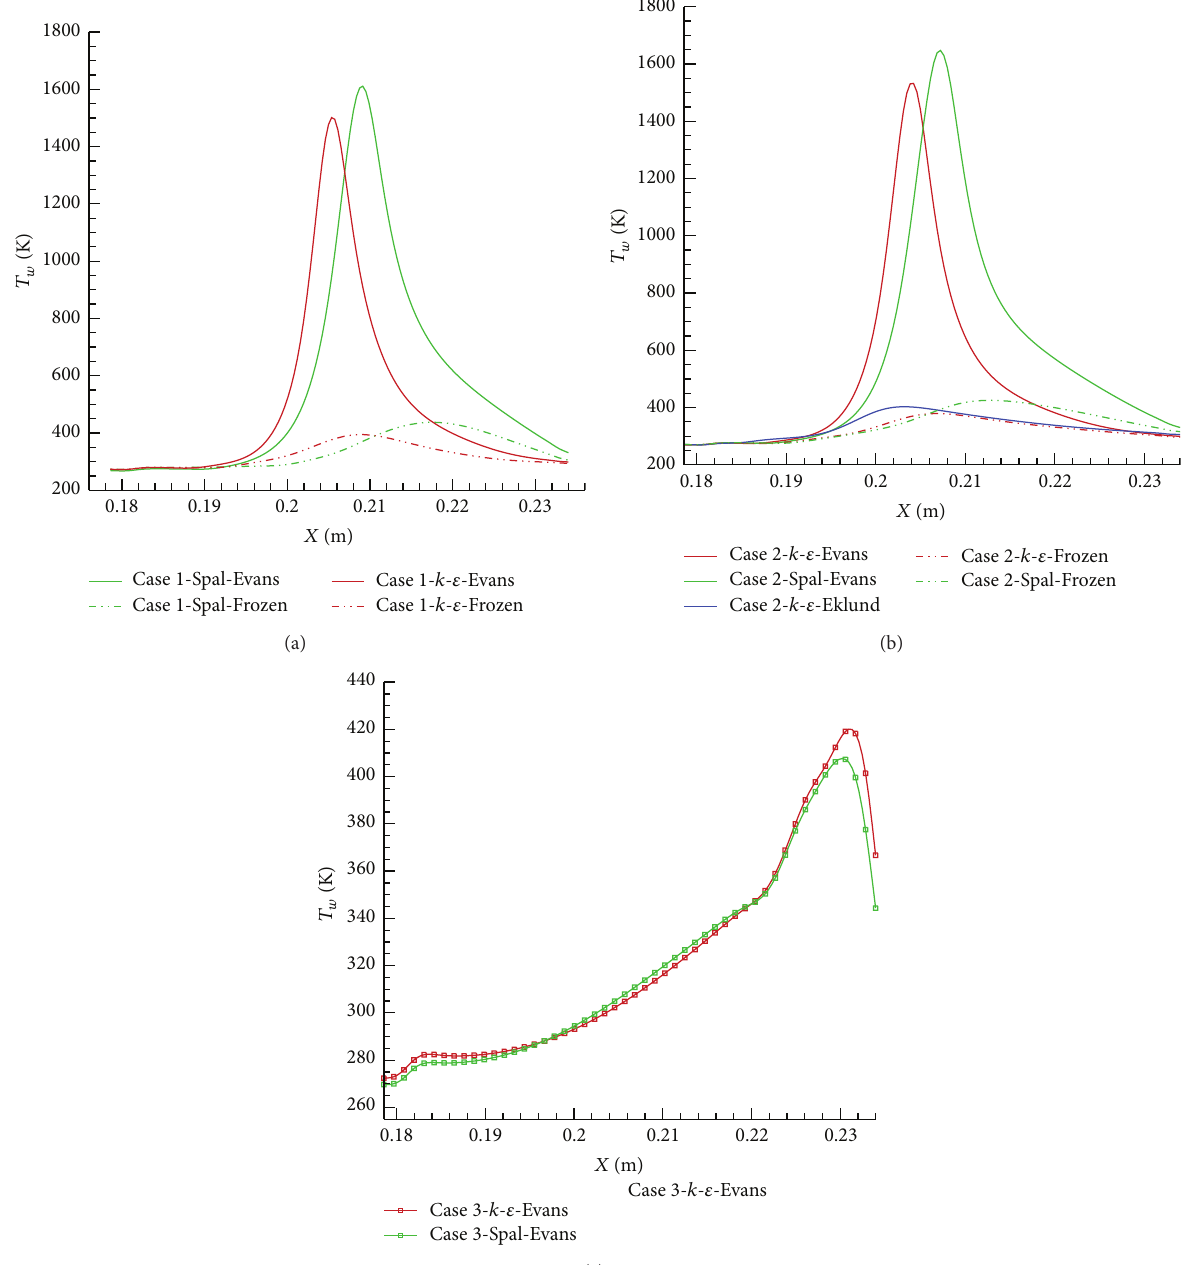
Figure 10: Calculated OH concentration and flow temperature Case 3, Evans and 𝑘 - 𝜀 calculation. The combustion takes place outside the nozzle.